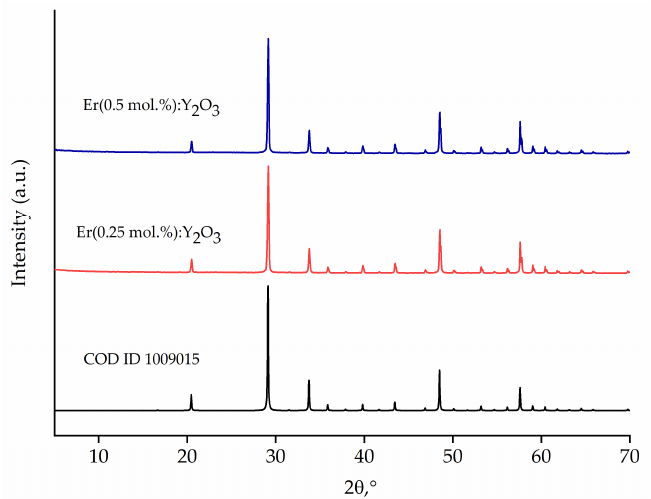
Figure 2. PXRD patterns of Er (0.25 and 0.5 mol.%):Y 2 O 3 ceramics samples compared with the theoretical pattern for Y 2 O 3 (COD ID 1009015).